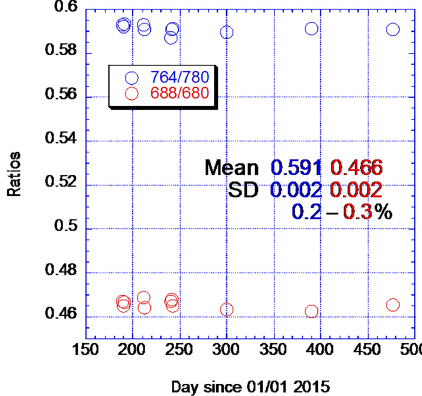
Figure 9. Ratios of O 2 absorbing to reference channels using EPIC moon observations. The data shown are for full moon. The new moon data on day 609 (not shown) provided the same channel ratios as the full moon